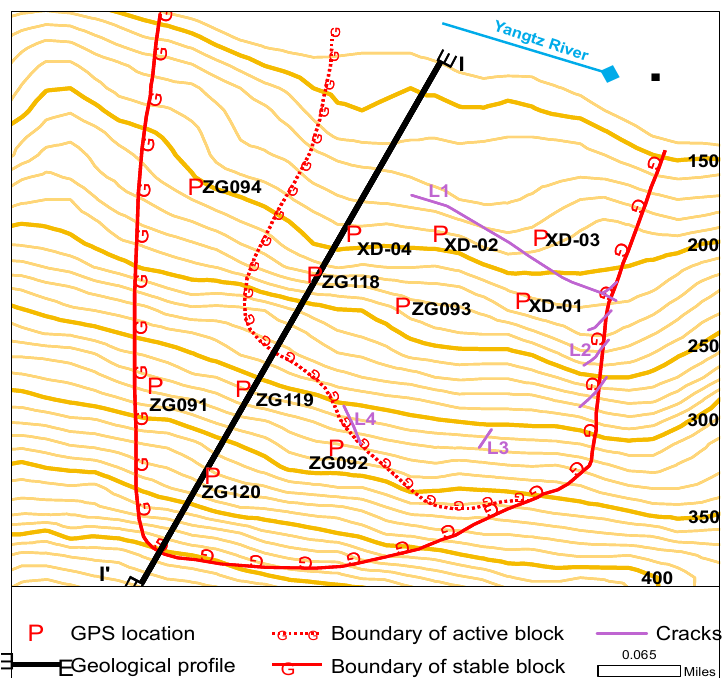
Figure 7. Location map of the study area.